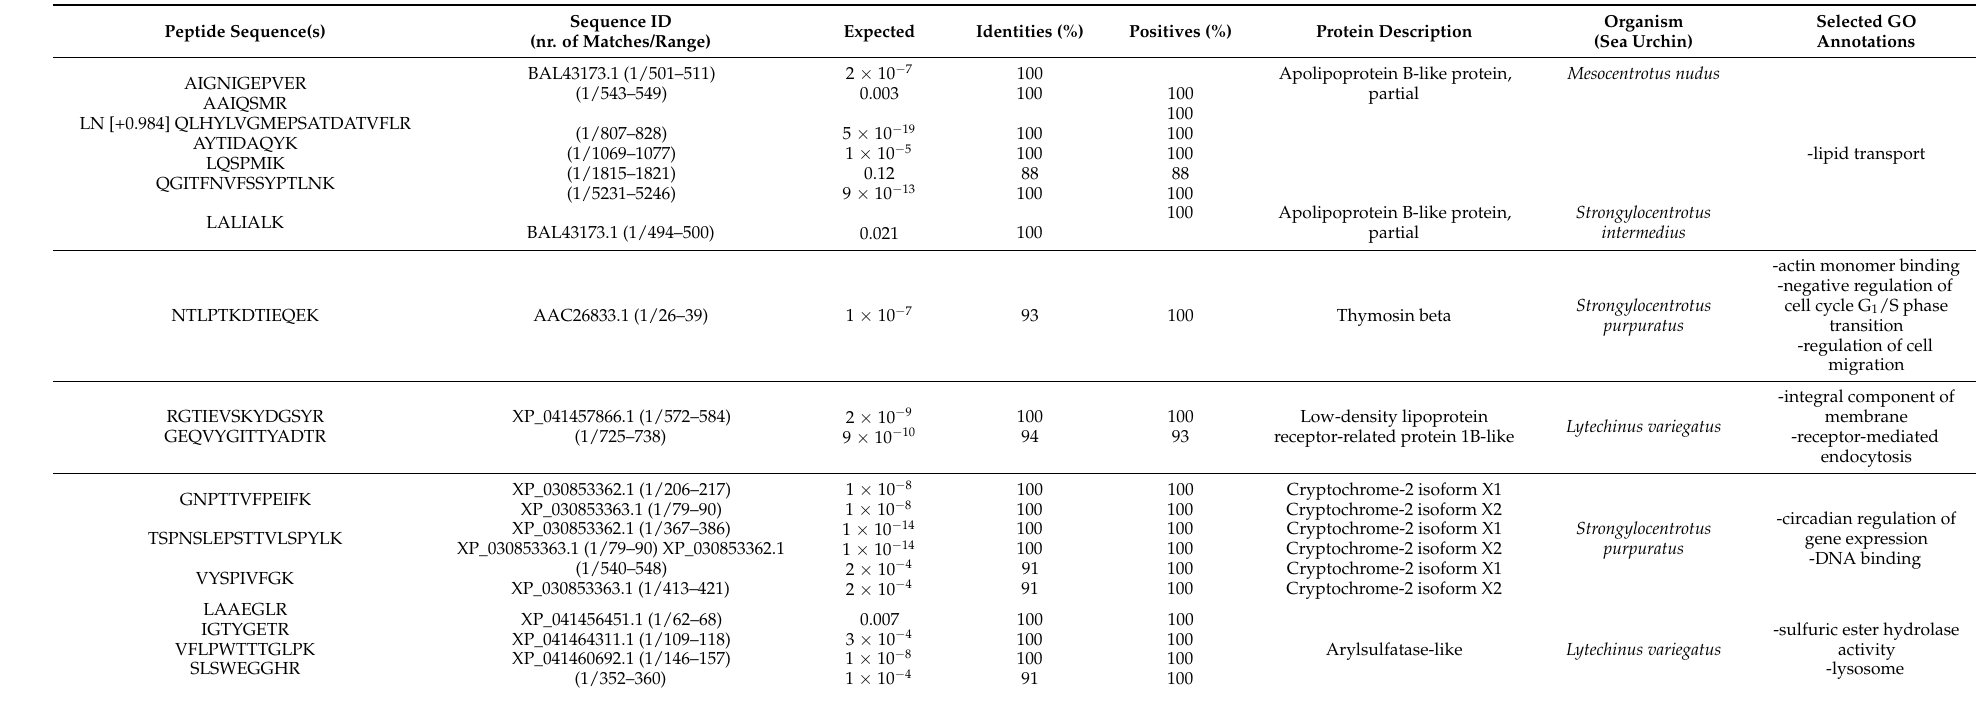
Table 1. Cytotoxic activity-associated protein profile of the CFE from A. lixula . Peptide Sequence(s) Sequence ID (nr. of Matches/Range) Expected Identities (%) Positives (%) Protein Description Organism (Sea